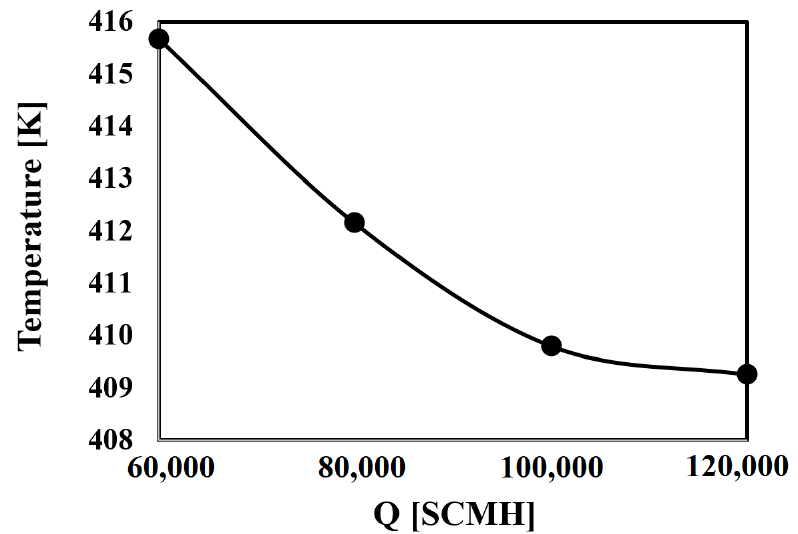
Figure 15. The variation in the fire tube outlet temperature against the inlet mass flow rate.